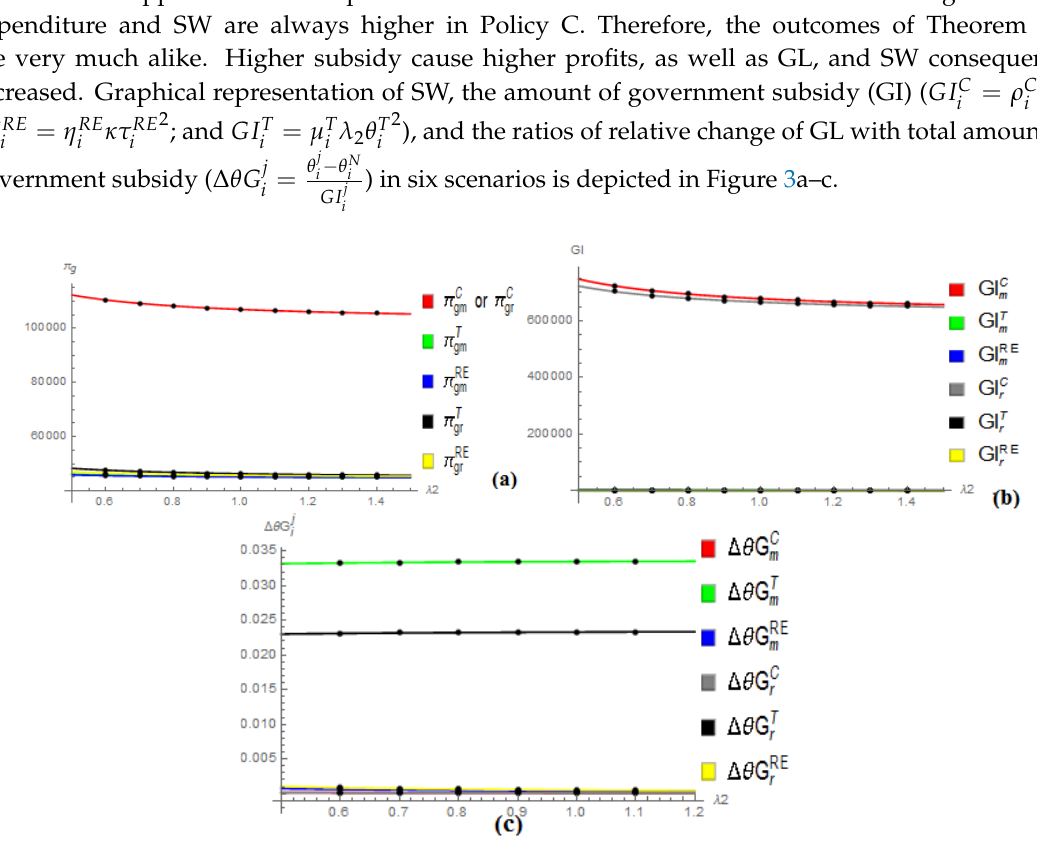
Figure 3. Graphical representation of ( a ) social welfare, ( b ) total amount of government subsidy in each scenario, and ( c ) ratios of relative change of greening levels with total amount of government subsidy in Scenarios MC, RC, MRE, RRE, MT, and